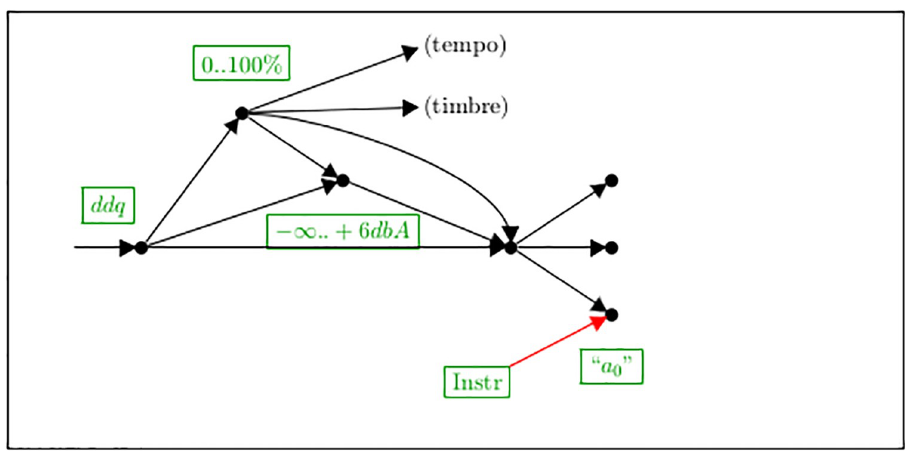
Fig 21. Possible further transformation